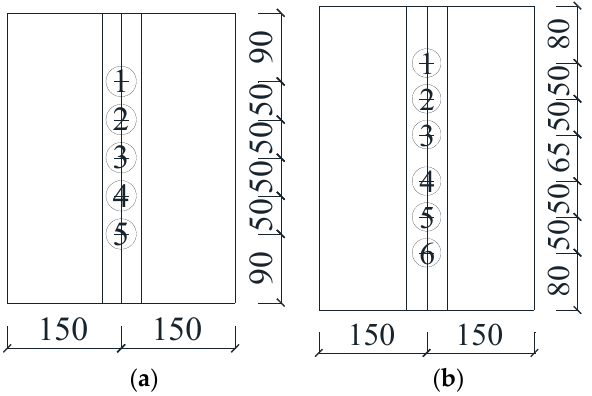
Figure 5. The schematic diagram of the different detecting points. ( a ) Detecting points of SJ1 group, ( b ) Detecting points of SJ2, SJ3, and SJ4 group.